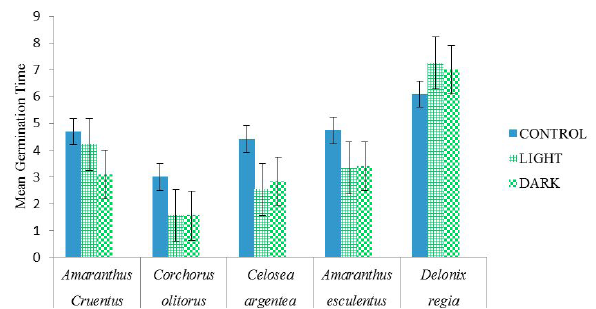
Fig. 6. Mean Germination Time of the varieties under different treatments